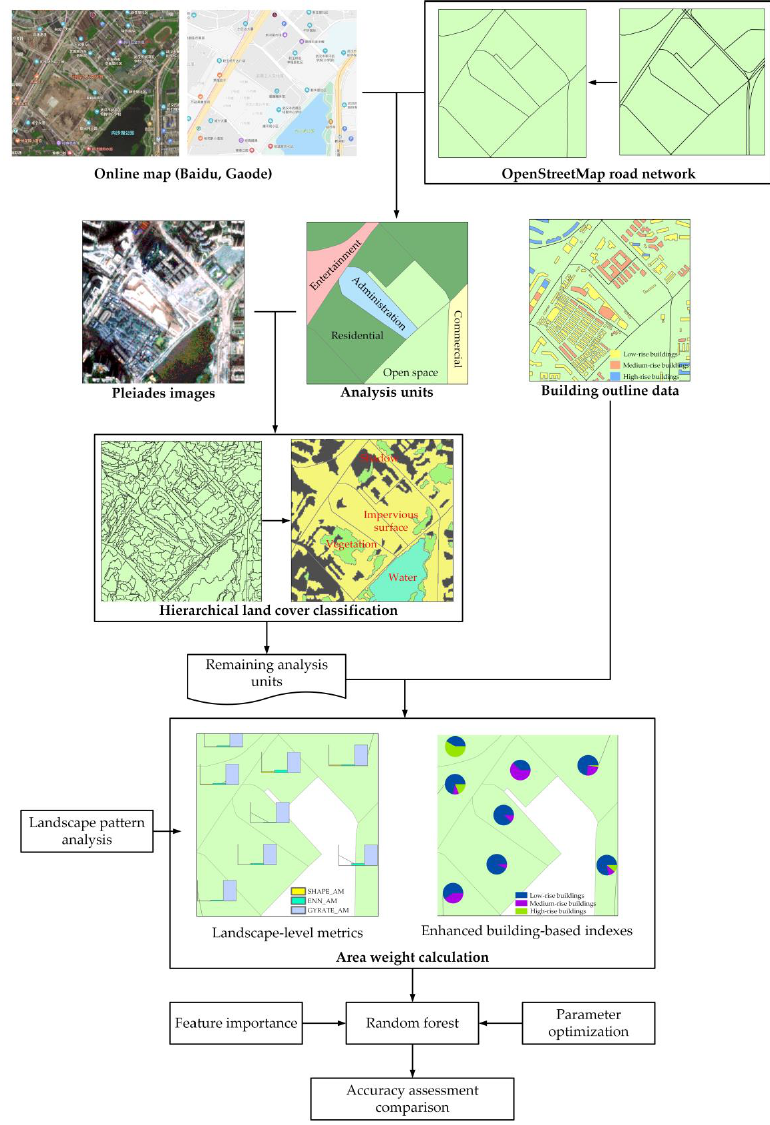
Figure 3. The workflow of the proposed method.